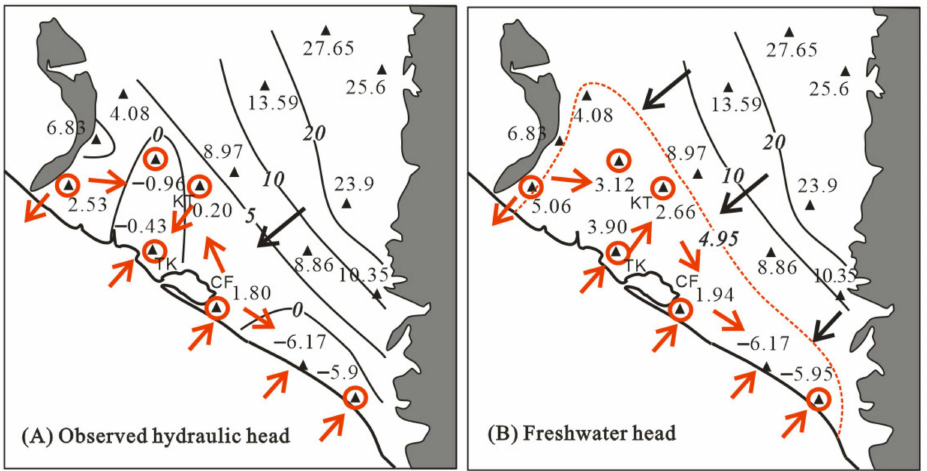
Figure 6. ( A ) Observed annual hydraulic heads (m) within aquifer F3-2 during 2012. ( B ) Freshwater heads were calculated based on observed annual hydraulic heads, EC, and mean screen level. Observation wells marked with a red circle were saline groundwaters with an EC > 1500 µ S/cm, which represent a potential seawater intrusion area. Black arrows indicate the flow directions of fresh groundwater, while the flow directions of saline groundwater are marked by red arrows. The depth of aquifer F3-2 is approximately 150–230 m, with an average depth of 190 m. The freshwater head of seawater at a depth of 190 m is approximately 4.95 m (red dashed